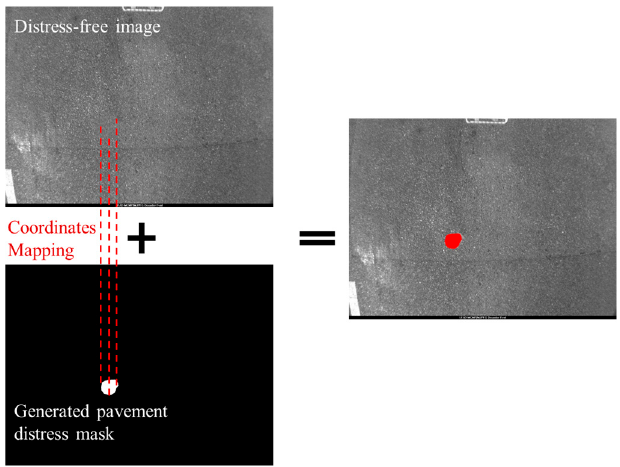
Figure 10. Image fusion procedure. The red mark shows the generated pit mask.